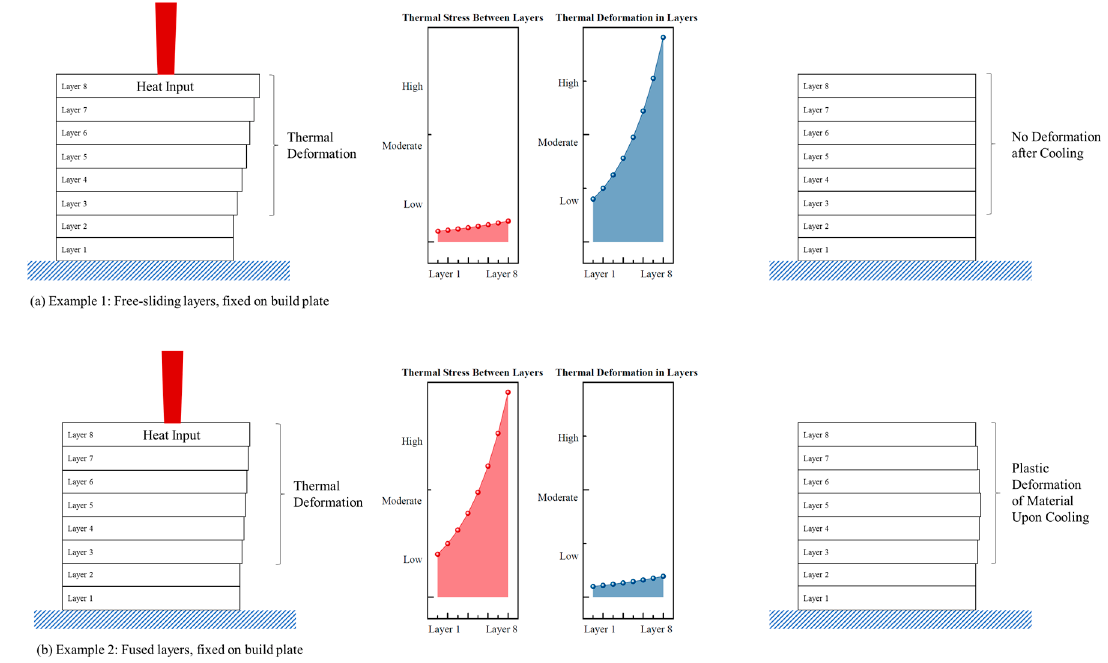
Figure 3. Stress between layers.